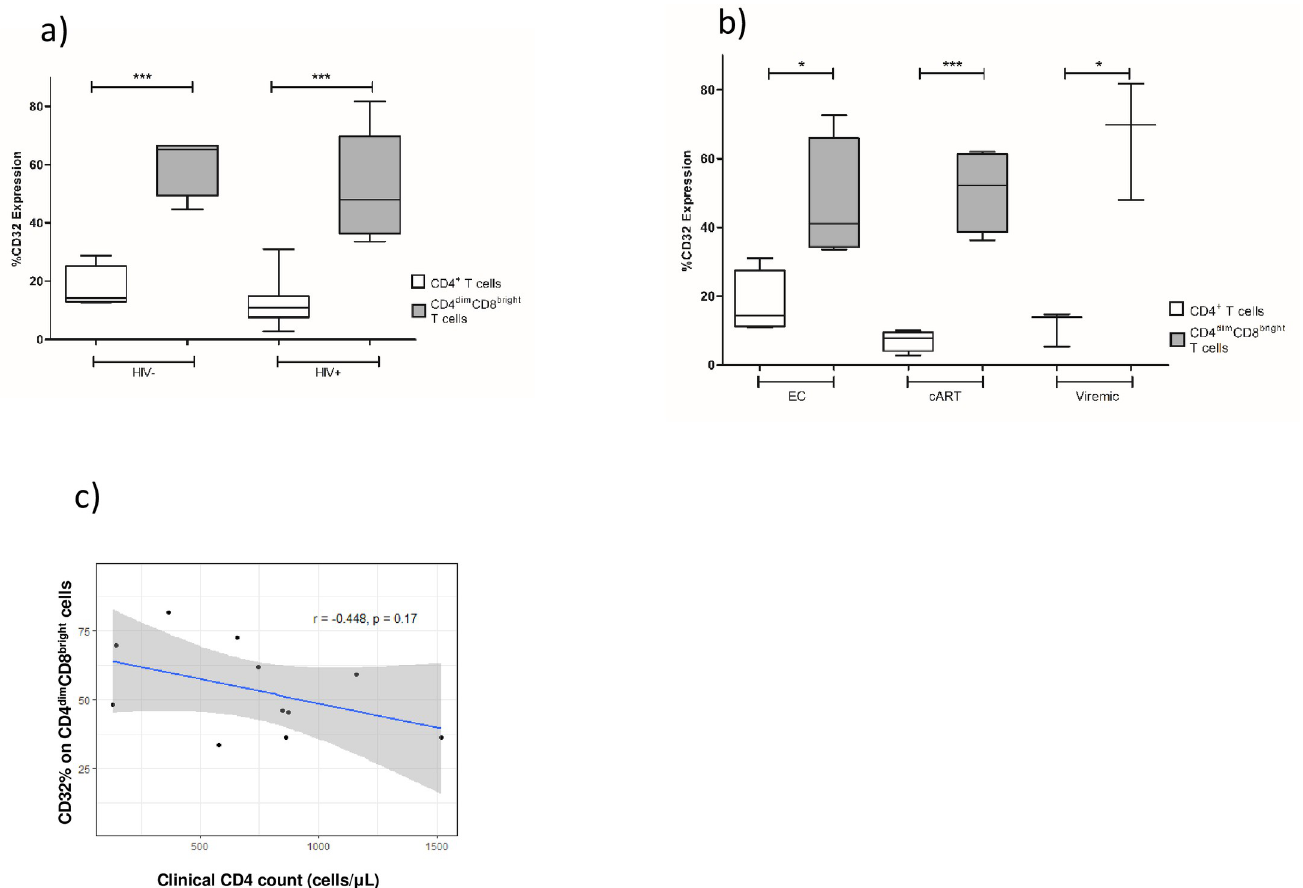
Fig 2. CD32 expression on CD4 + and CD4 dim CD8 bright T cells among HIV seronegative and seropositive donors. a ) CD32 expression on CD4 dim CD8 bright T cells and CD4 + T cells from HIV + and HIV - blood donors was evaluated by flow cytometry using peripheral blood of HIV seronegative (n = 4) and HIV seropositive (n = 11 donors). b ) PBMCs from elite controllers (EC) (undetectable viral loads for > 5 years) including one long term non-progressor (high viral load, CD4 > 500 cells/ μ L), cART adherent (viral load < 40 copies/mL), and cART non-adherent/ treatment na ï ve (viremic) (viral load > 10,000 copies/mL, CD4 count < 500 cells/ μ L) donors were evaluated by flow cytometry for CD32 expression. c ) Relationship between CD32 expression on CD4 dim CD8 bright T cells and CD4 count of HIV + participants. Clinical CD4 counts taken on day of blood draw. � denotes p < 0.05 determined by unpaired T-test and ��� denotes p < 0.01 as measured by paired T-